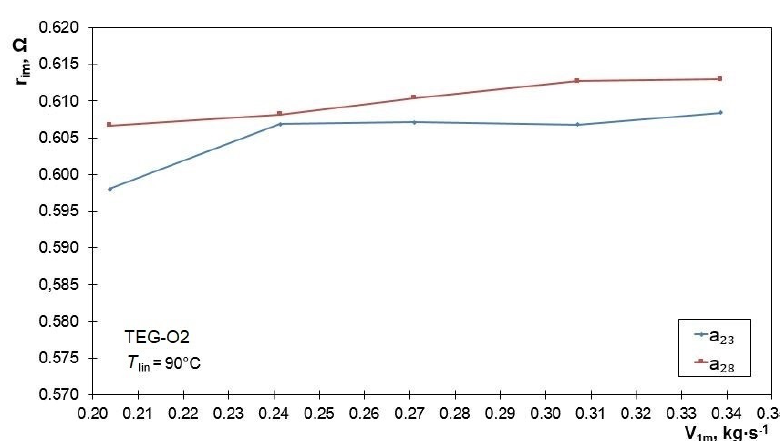
Figure 15. Characteristics of changes in the internal resistance of selected TEGs as a function of the flow rate V 1 m